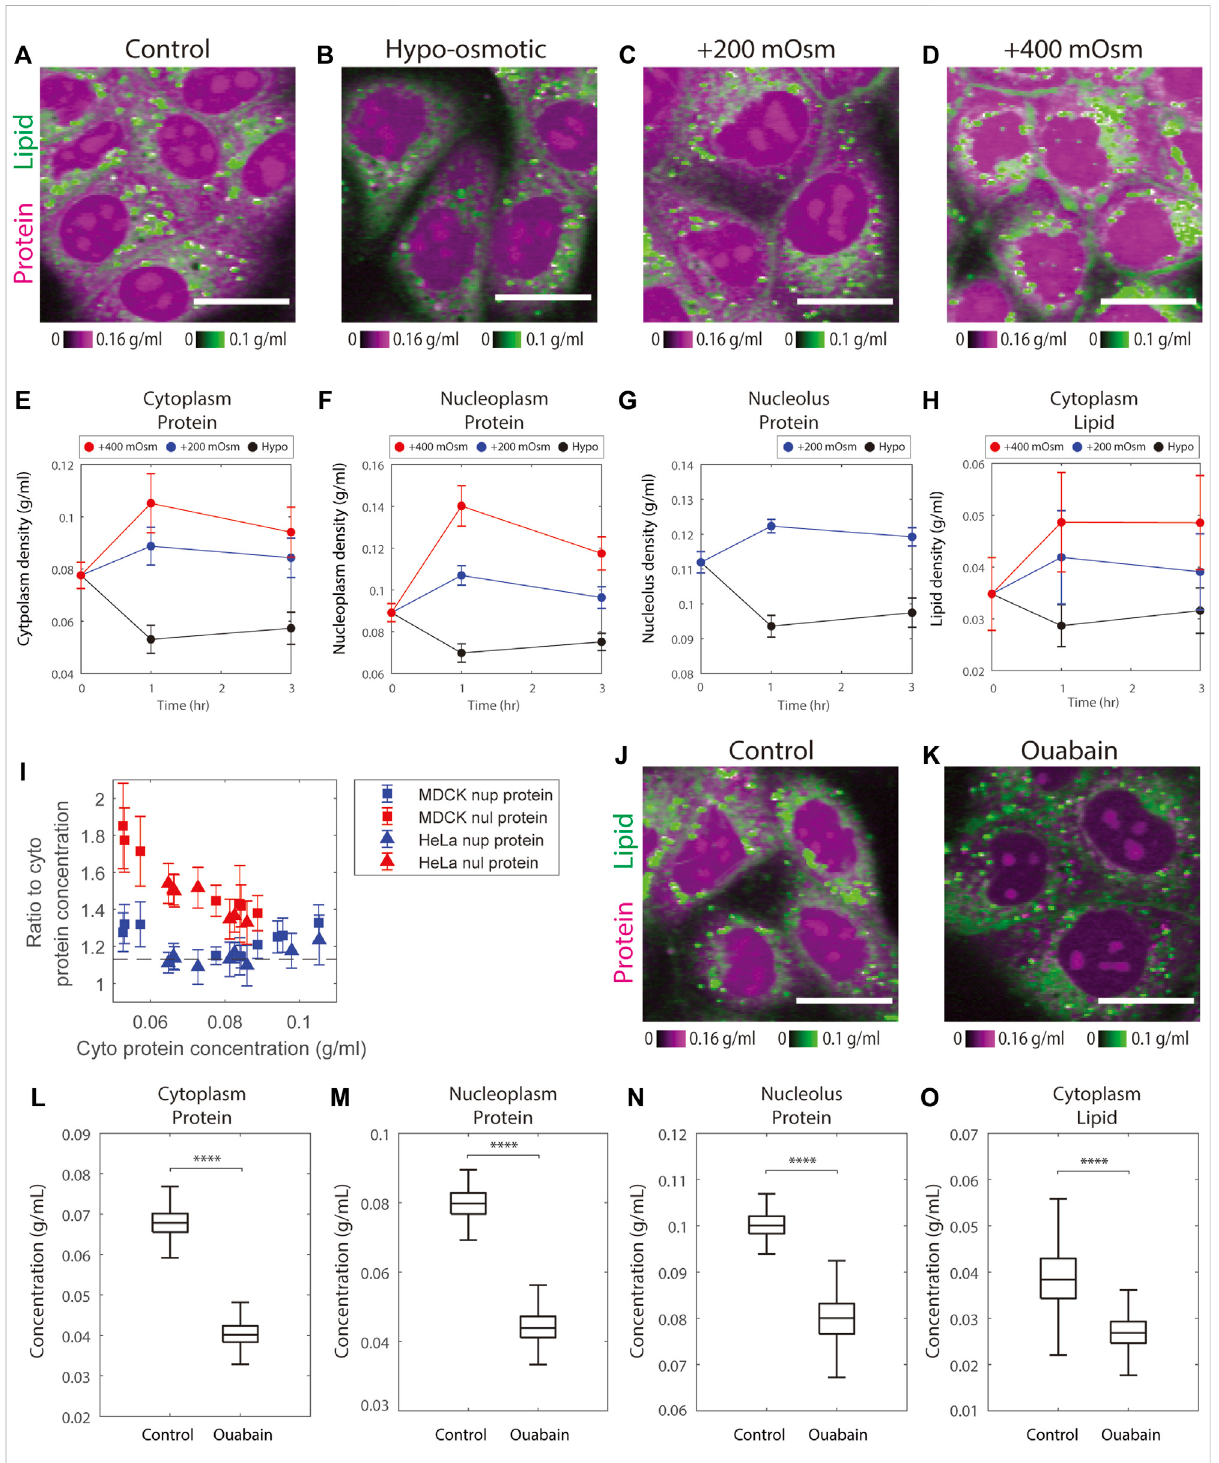
FIGURE 4 Osmoticstressaltersproteinandlipiddensities. (A – D) RepresentativeNoRIimagesofcontrolMDCKcellsincompletemediumandMDCKcellsafter 3 hin hypo-osmoticorhyper-osmoticmedia.Scalebar,20 µm. (E – H) Timecourseofproteinandlipiddensitychangebyhyper-osmoticandhypo-osmotictreatment. Time 0 shows the control sample. Data points and error bars are the mean and standard deviation. The number of cells in each data point is between 452 and 1204 cells,withameanof790 cells. (I) Theratioofnucleoplasm(nup)ornucleolus(nul)proteindensitytocytoplasmproteindensityversuscytoplasmprotein densitymeasuredinthecontrol,hypo-,andhyper-osmoticmedia.Thedashedlineindicatesthemeanratiobetweennucleoplasmandcytoplasmproteindensity fromFigure2J. (J – K) RepresentativeNoRIimagesofcontrolMDCKcellsandMDCKcellstreatedwith3 µMouabainfor5 h.Scalebar,20 µm. (L – O) Changeof protein and lipid density in cytoplasm, nucleoplasm, and nucleolus in MDCK cells treated with 3 µM ouabain for 5 h. n = 548 (Control). n = 665